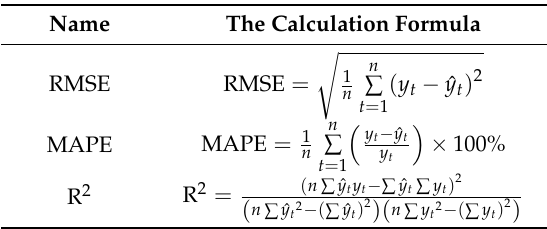
Table 6. The calculation